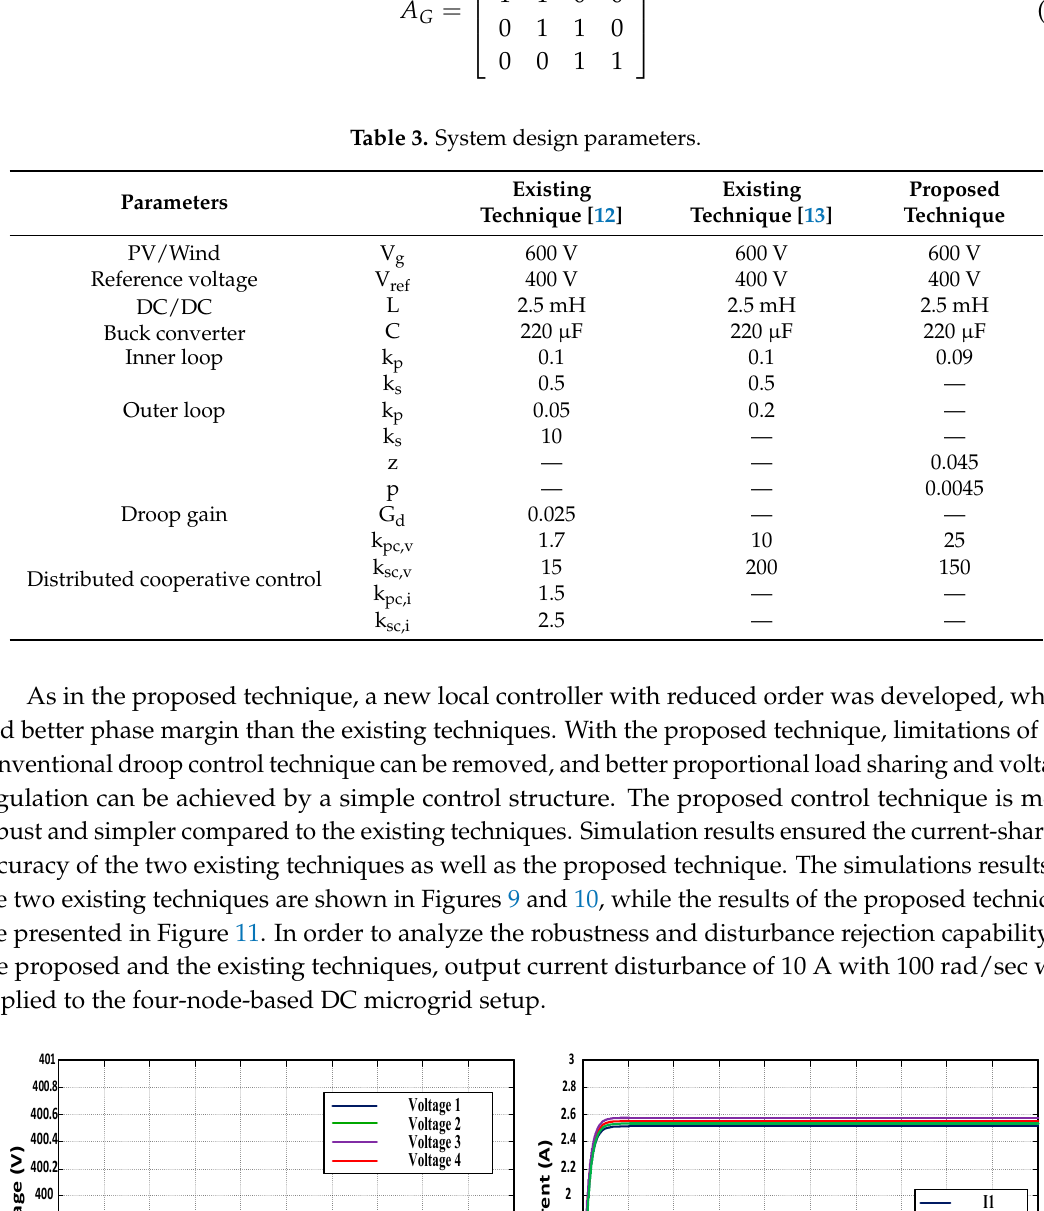
( b ) Figure 10. Existing technique [13] with ring communication structure. ( a ) Voltage waveform, ( b ) Current waveforms. 399.6399.8400400.2400.4400.6 400.8 401 399.4 399.2 399 0 ( b ) Figure 11. Proposed technique [12] with ring communication structure. ( a ) Voltage waveform, ( b ) Current waveforms. The response of voltage restoration and current sharing of the two existing techniques are shown in Figure 12 and Figure 13, while that for the proposed technique is shown in Figure 14. The convergence time of the conventional droop-control-based technique [12] was 0.07 s, while the convergence time of the other technique [13] was 0.06 s. The disturbance response for the proposed technique is depicted in Figure 14. The convergence time of the proposed technique was 0.035 s which was 50% less than the conventional droop-based controller, while the other controller time was almost 85% of the droop-based technique. In the presence of disturbance, the proposed technique converged to its reference level in very little time, which showed that the finite-gain controller facilitated faster convergence and better robustness to disturbance. Due to the disturbance effect, the current-sharing accuracy of the conventional droop-based controller was affected, while the